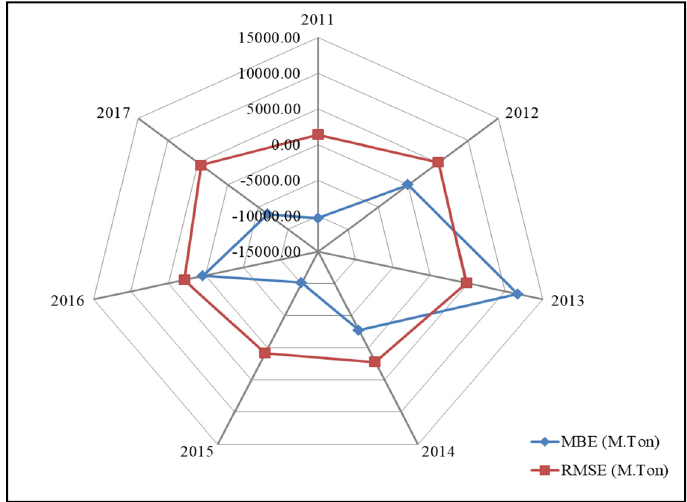
Figure 5. Radar chart shows statistical accuracy of Remote Sensing (RS) model simulation for each